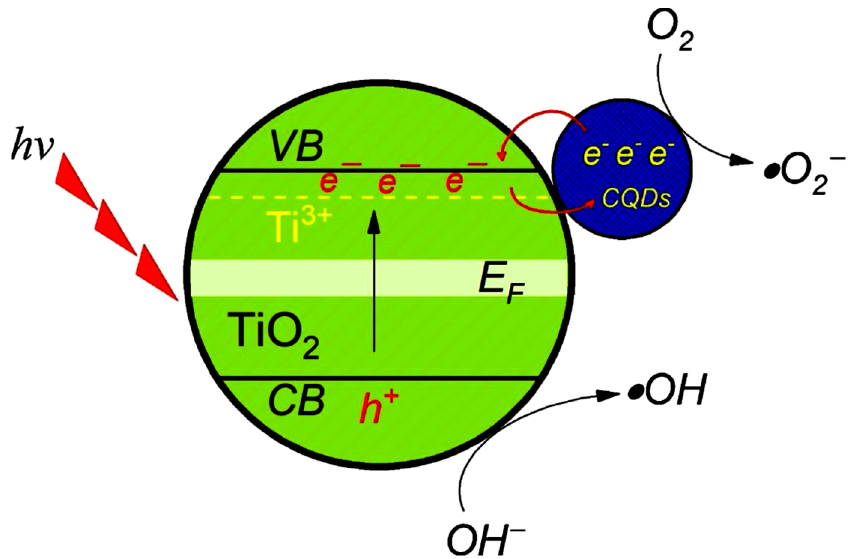
Figure 15. Schematic illustration depicting the surface interactions between CQDs and TiO 2 NPs. Illumination with light excites charges in TiO 2 that transfer to the CQDs. Reprinted/adapted with permission from Ref. [295]. 2021, Elsevier.